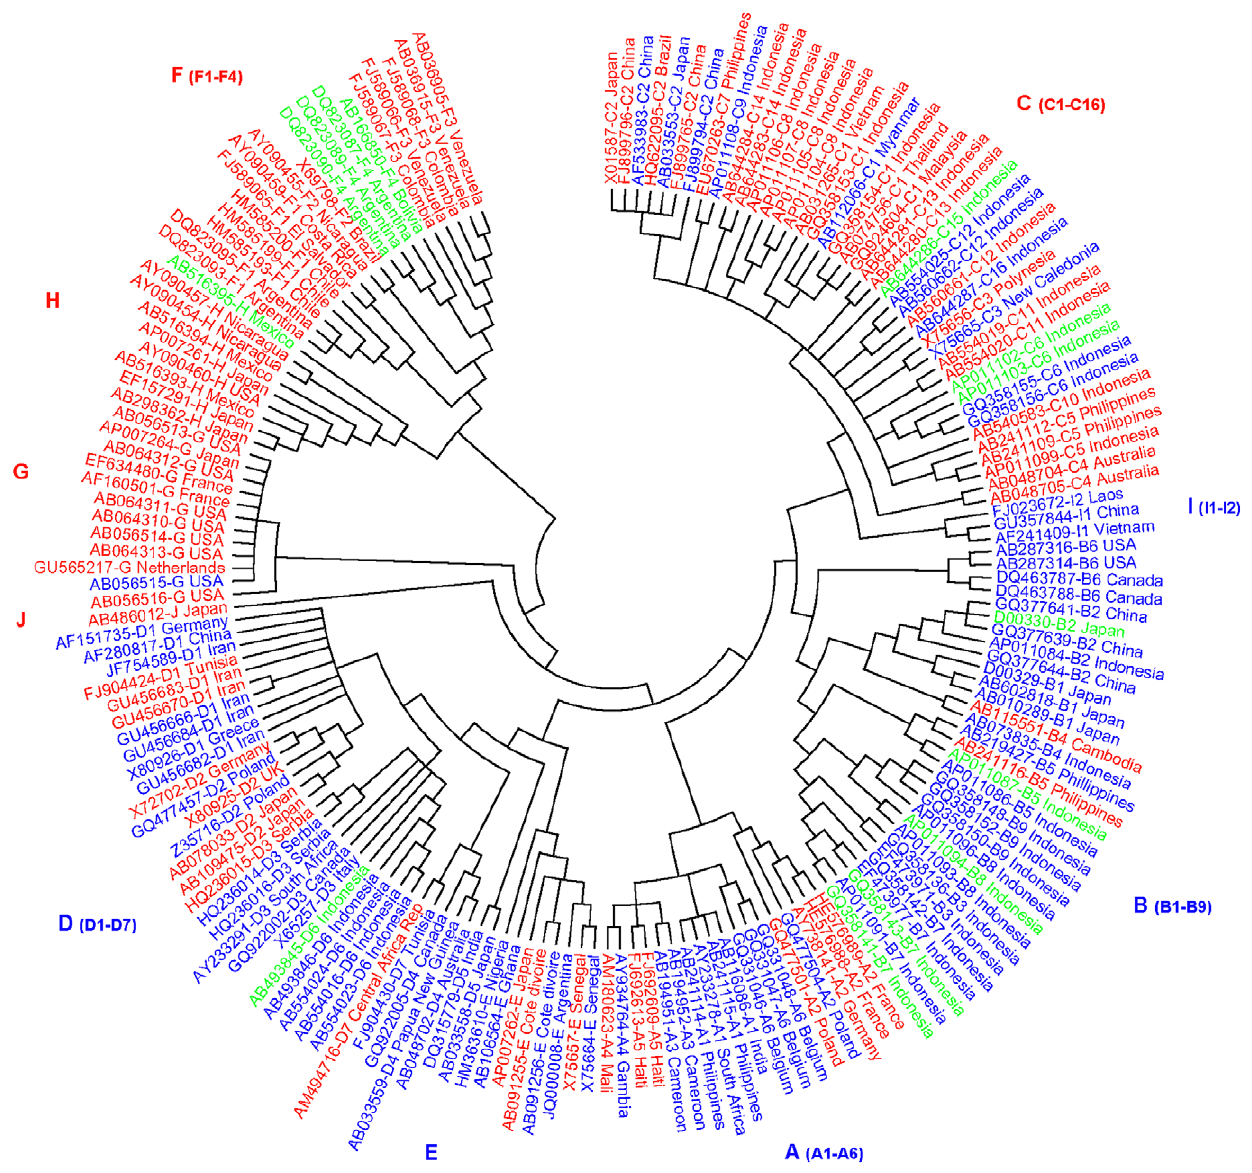
Figure 2. Dendrogram based on 176 complete genomic sequences of HBV with genotypes A–J. The phylogenetic tree was constructed using the UPGMA method. The genotypes are marked by the letters A through J. Each sequence is identified by the GeneBank accession number, followed by the genotype/subgenotype and the country of origin of the isolates. HBV genomes containing three, two, and four CpG islands are shown in blue, red, and green,